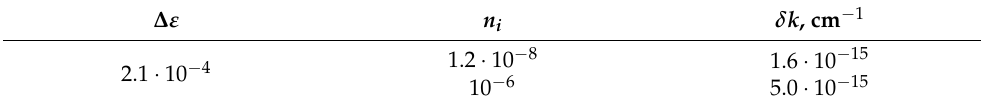
Table 6. The widths of transmission curves δ k for different modulation amplitudes ∆ ε and absorptions. λ = 630 nm, L = 0.75 cm, d = 1